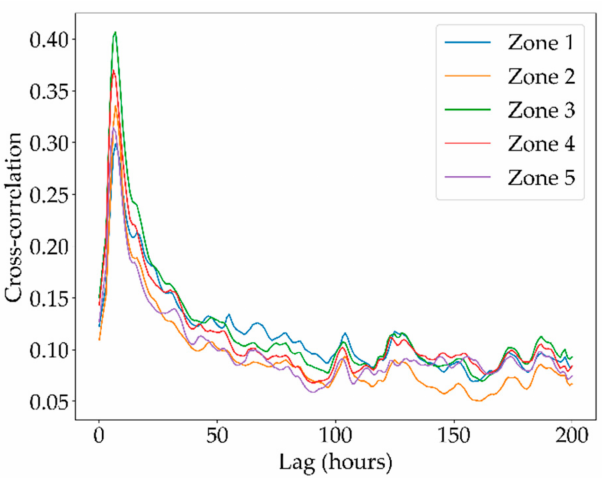
Figure 4. Pearson’s correlation between the five precipitation time series (one for each region) and the runoff time